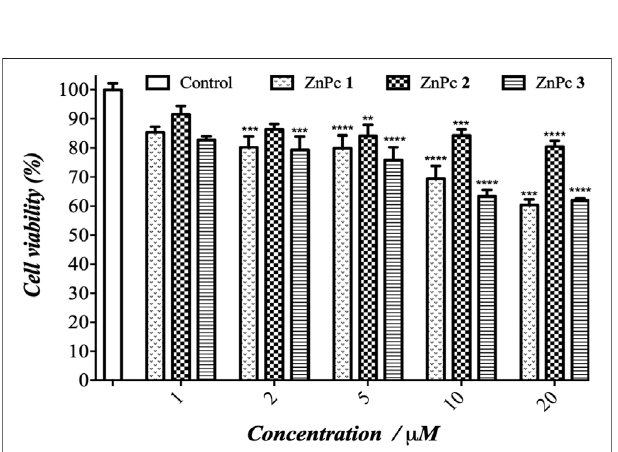
FIGURE 3 | Dark cytotoxicity ofZnPcs 1 – 3 in B16F10 cells asa function of PS concentration. The results are presented asmean ± standard deviation. Statisticalsigni fi cance:** p < 0.01,*** p < 0.001,and**** p < 0.0001 vs. control.